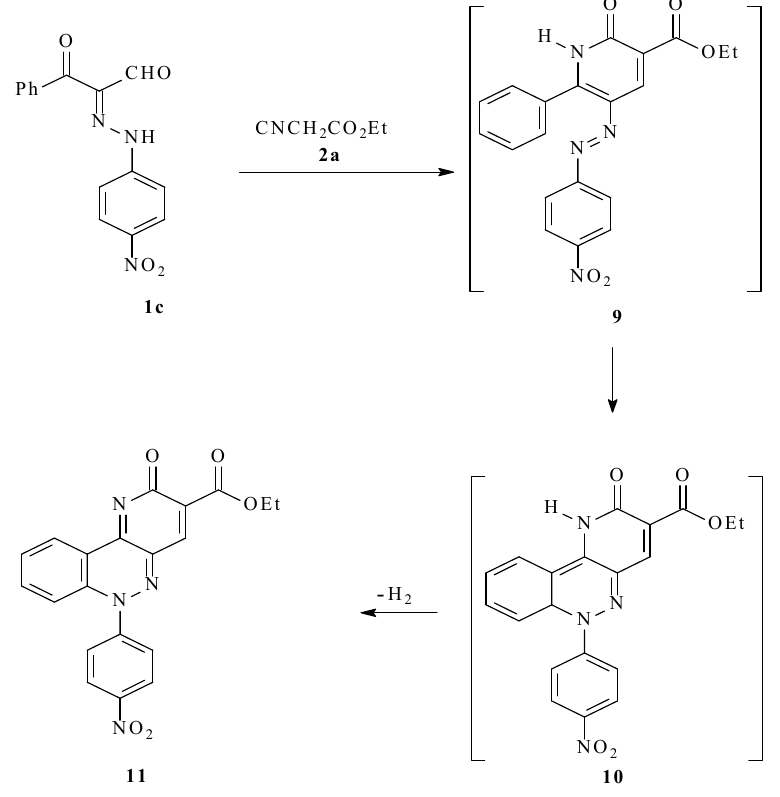
Scheme 2. Synthesis of ethyl 6-(4-nitrophenyl)-2-oxo-2,6-dihydropyrido[3,2-c]cinnoline- 3-carboxylate ( 11 ).